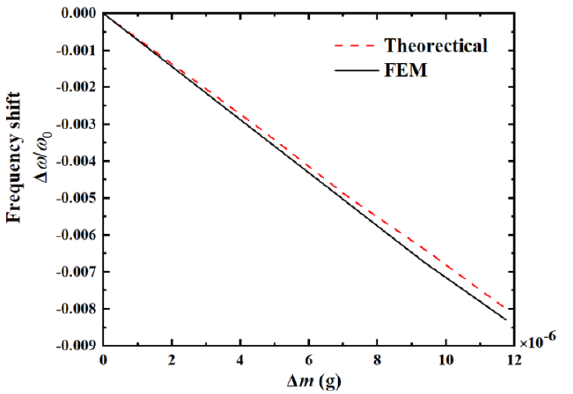
Figure 8. The influences of the added mass on the YCOB LFE device’s frequency shift. Figure 9 show the relationships between the frequency sensitivity on added mass vs.